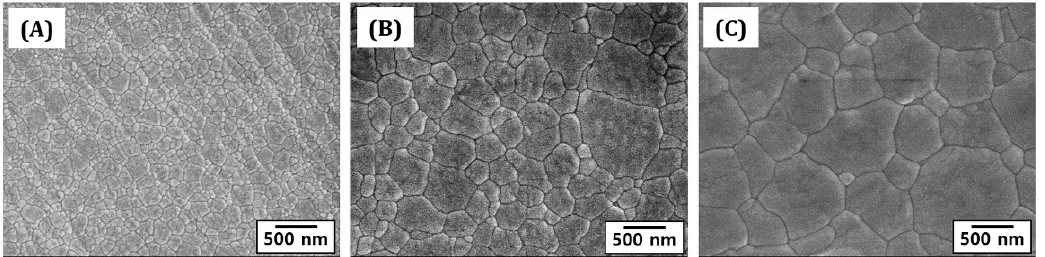
Figure 11. Representative FE-SEM images showing the free surfaces of 4Y-PSZ disks sintered for 3 h at various temperatures: ( A ) 1300 °C, ( B ) 1400 °C, and ( C ) 1500 °C.